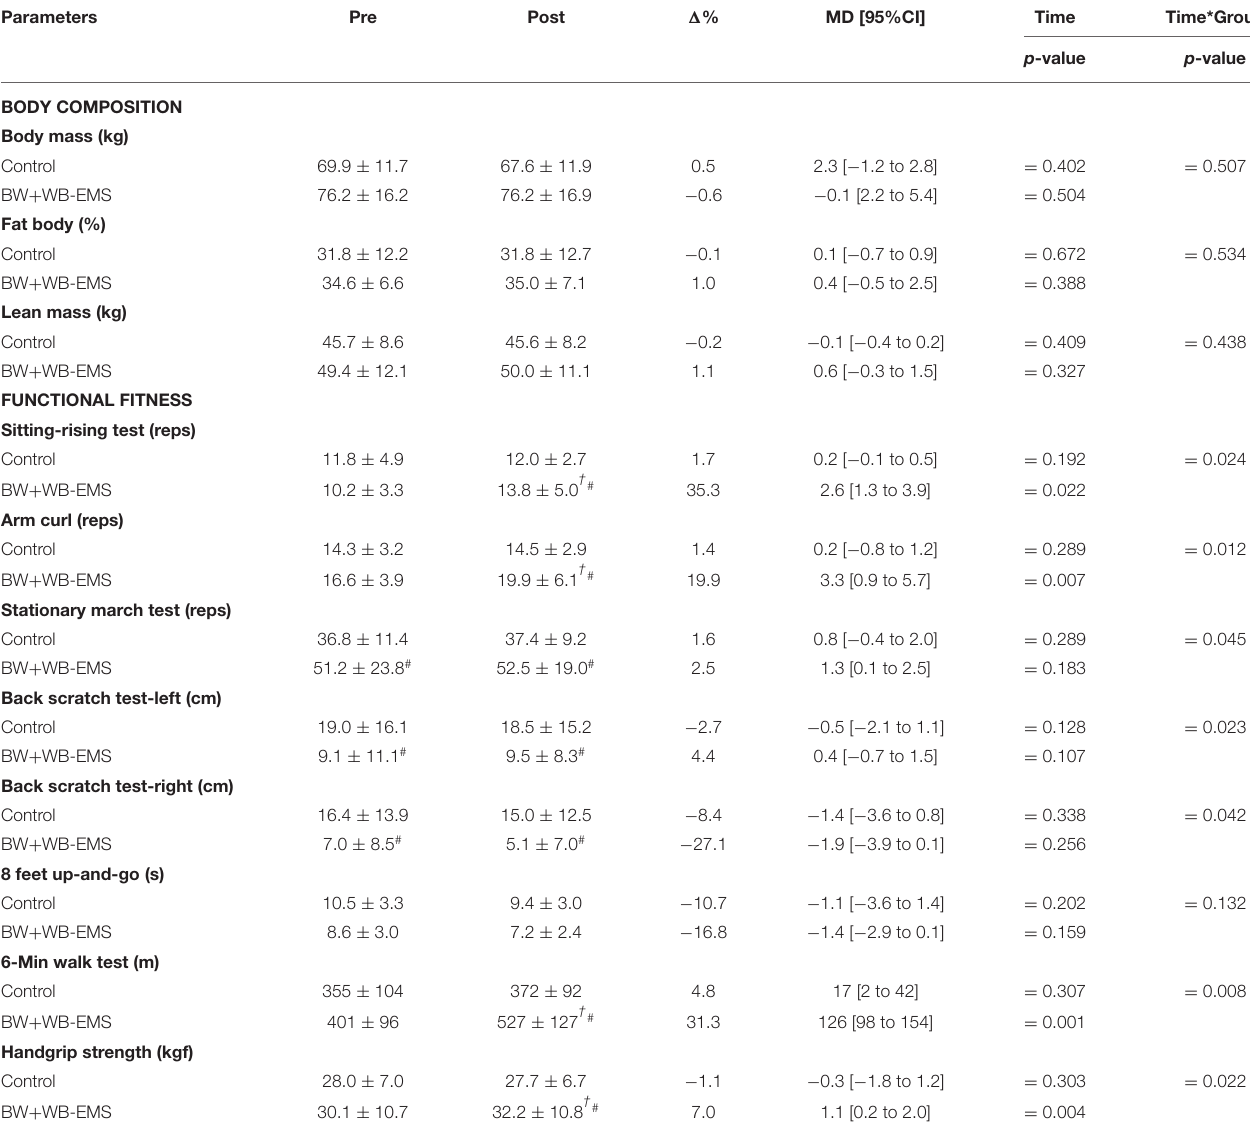
TABLE 2 | Alterations on body composition and functional fitness after 6 weeks of strength training combined with electrical muscle stimulation. Parameters Pre Post MD [95%CI]